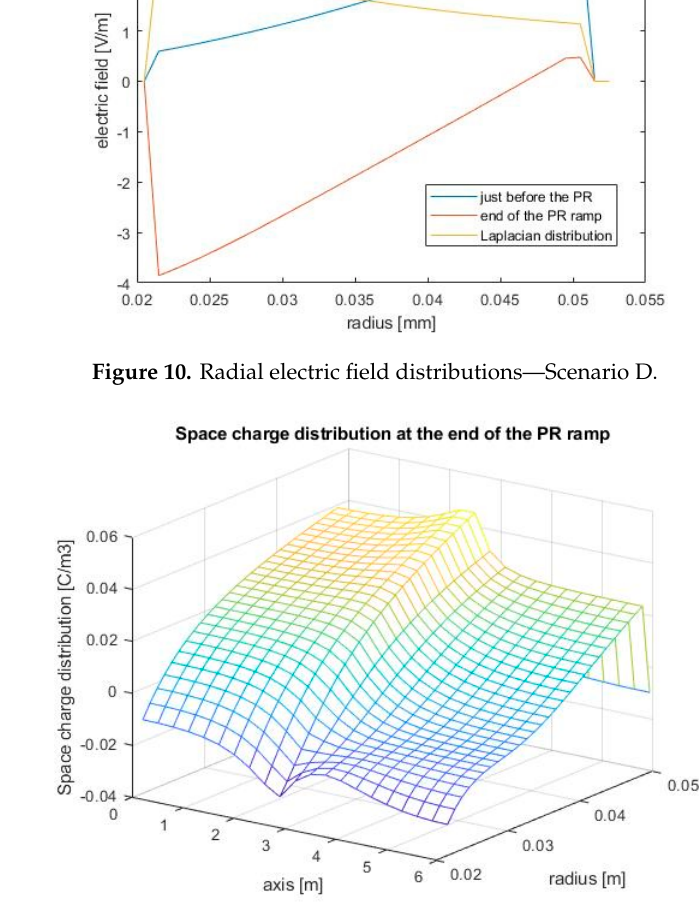
Figure 11. Space charge distribution at the end of the Polarity Reversal (PR) ramp—Scenario E.